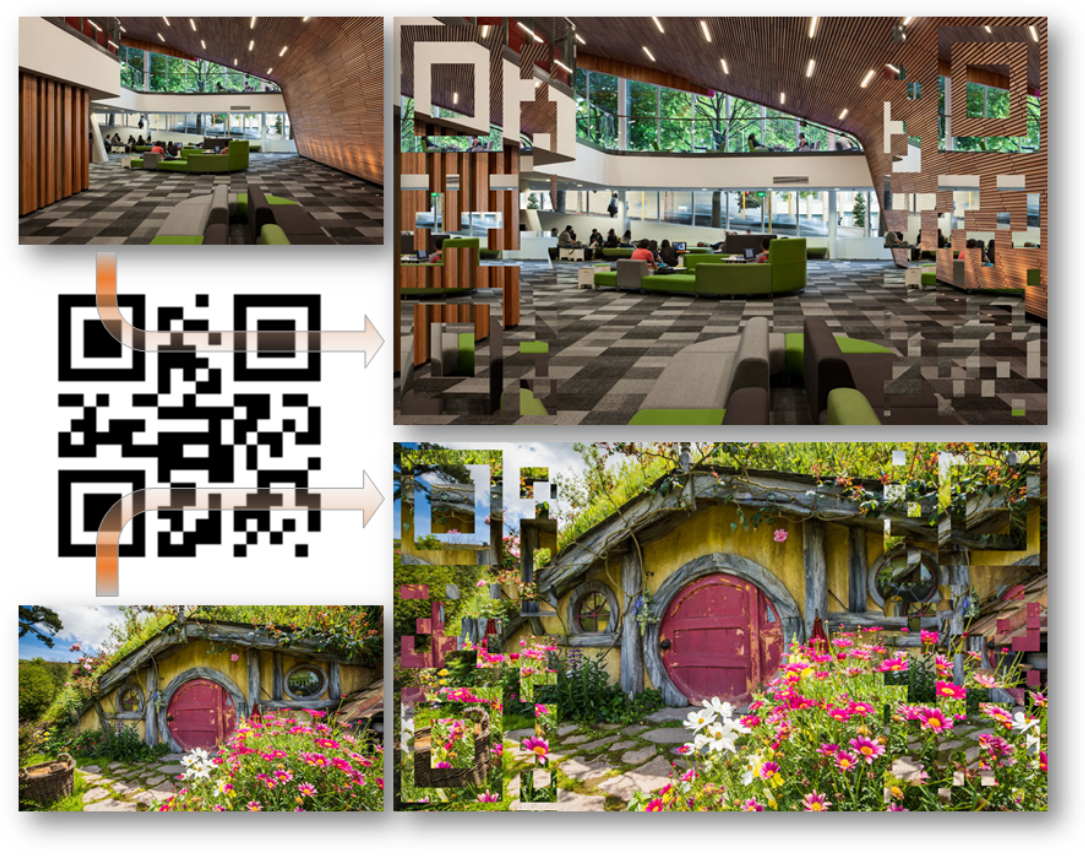
Figure 16. Examples of stereo card images that embed a full QR code.